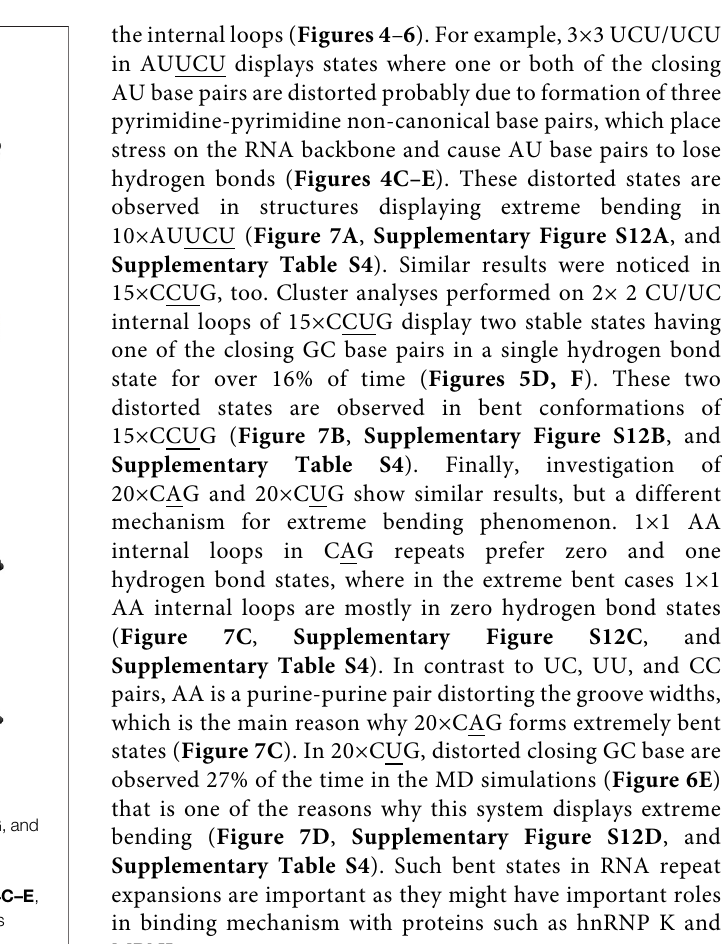
Figure 6E . As a result, UU pairs in RNA CUG repeats tend to stay away from two-hydrogen-bond states ( Figure 6F ), and sample mainly one- and zero-hydrogen-bond states ( Figures 6C,D ).